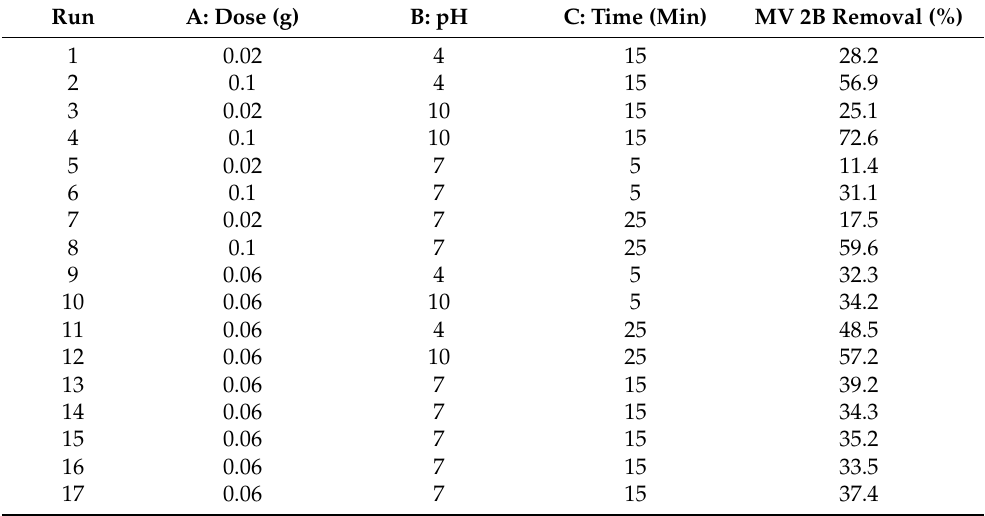
Table 2. Experimental matrix of BBD approach and corresponding response (MV 2B removal (%)).